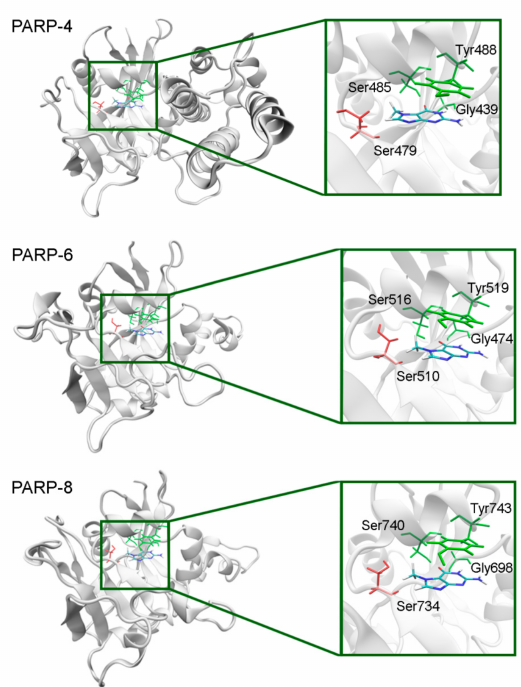
Figure 11. 7-MG position in the NA binding site of PARPs 4, 6, and 8 obtained using homology modeling. The conserved NA site residues are colored in green and unique residues in red. The C β atom of Ser479/510/734 forms a hydrophobic contact with the 7-MG methyl